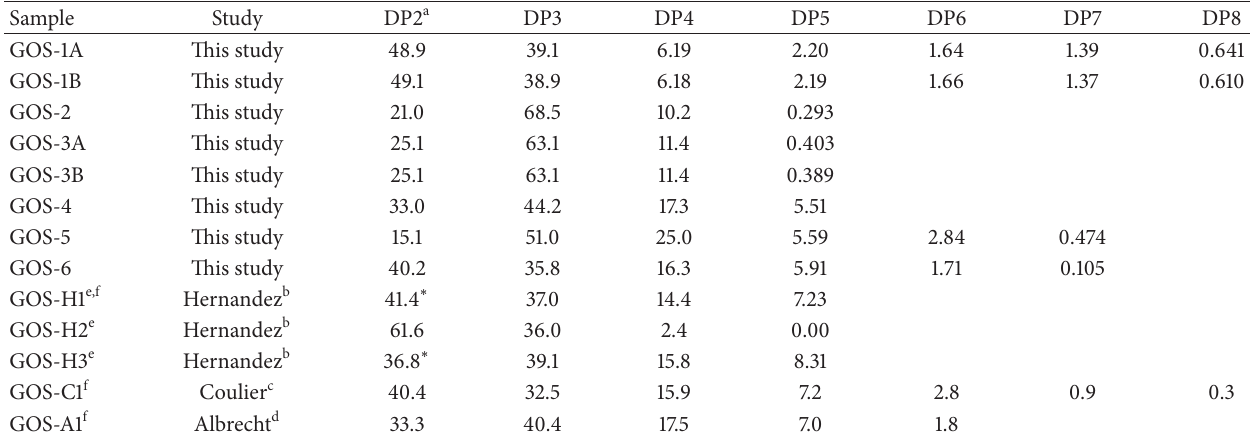
Table 7: Composition of different GOS ingredients in terms of oligosaccharide chain length.